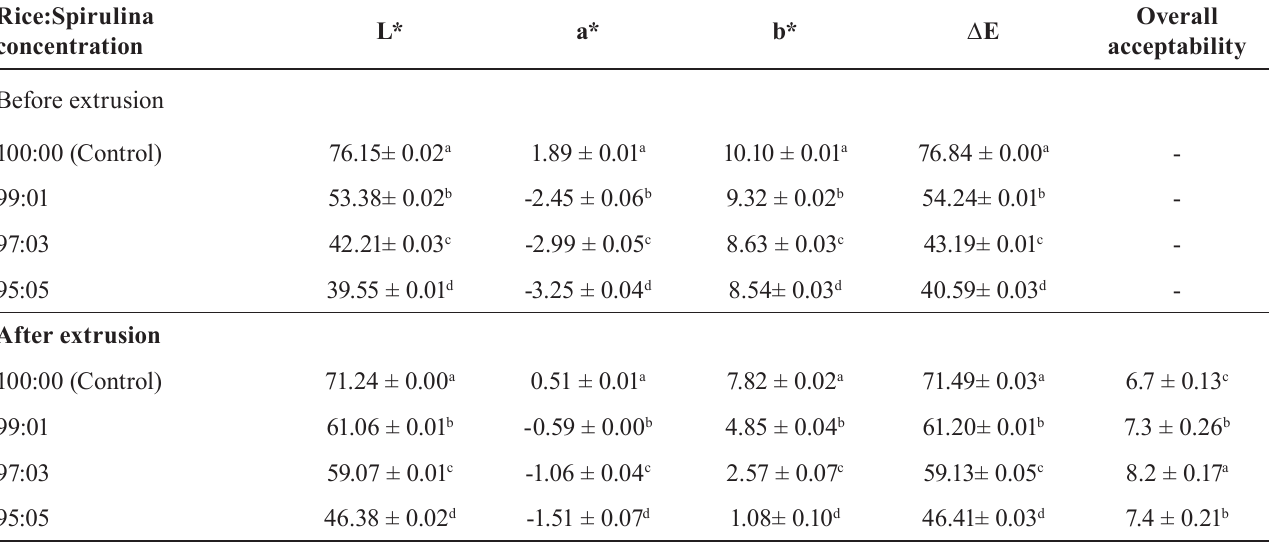
TABLE III - Effect of addition of Spirulina on colour properties of raw formulations and extrudates (i.e before extrusion and